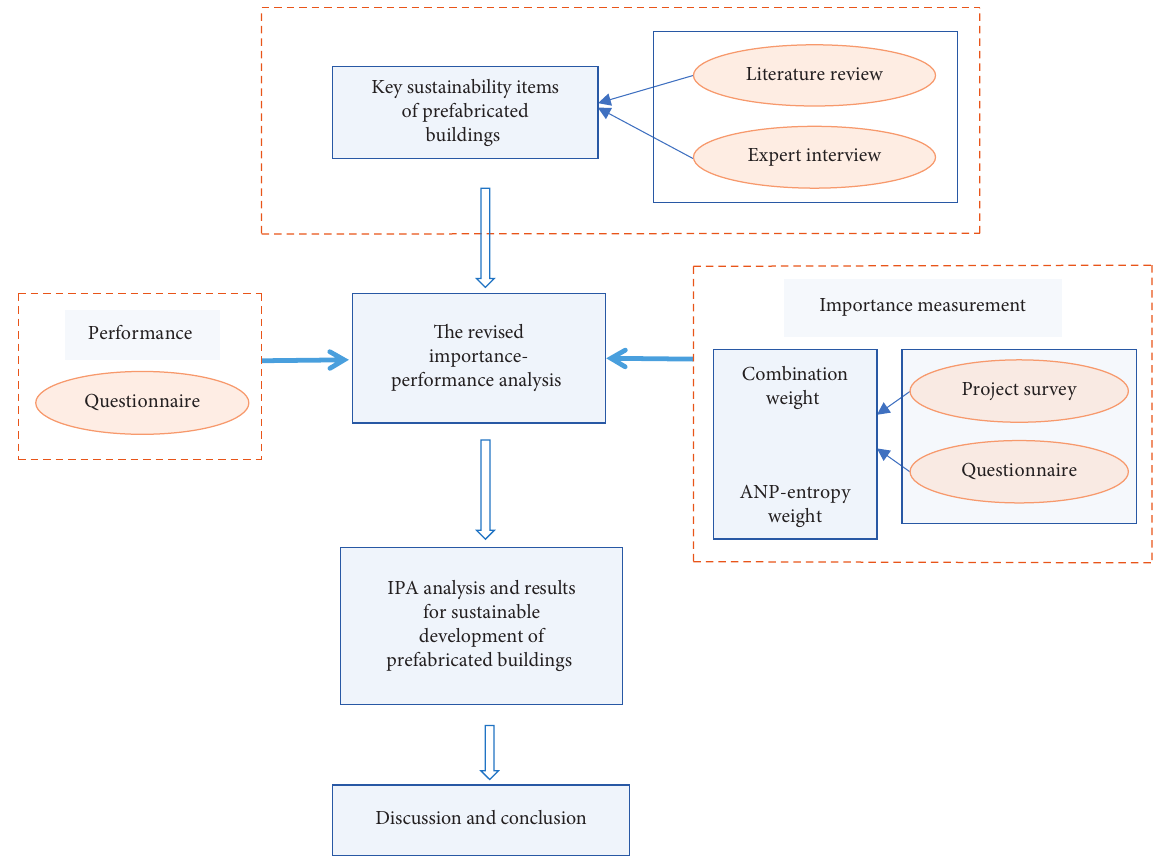
Figure 1: Research